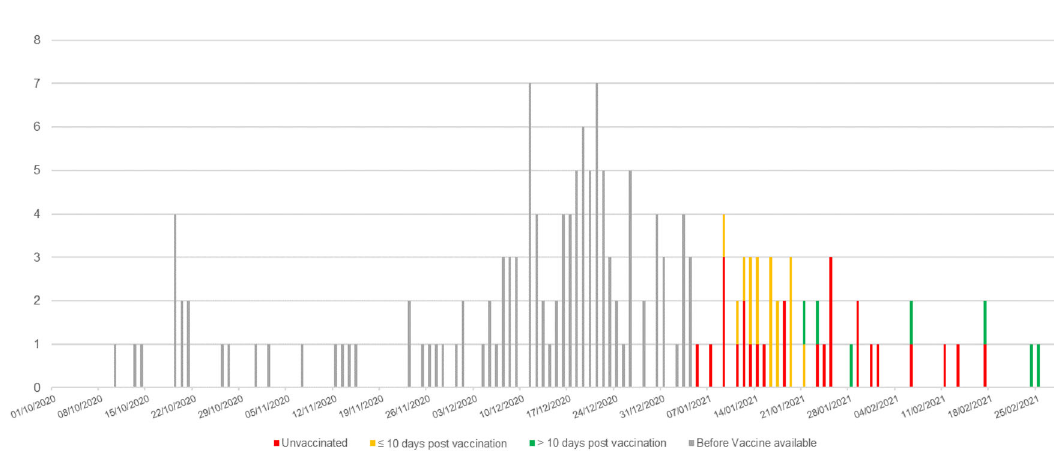
Fig. 2 New cases of COVID-19 occurring more or less than 10 days after receiving a single-dose BNT162b2 vaccine. A total of 49 new cases of COVID- 19 were following the start of BNT162b2 vaccination offered at the onsite hospital vaccination centre over a 2-week period from 5 January 2021. Of the 49 new cases, 26 (53.1%) were unvaccinated (red); 16 (32.7%) were within 10 days of vaccination (orange); and 7 (14.3%) were beyond 10 days of vaccination